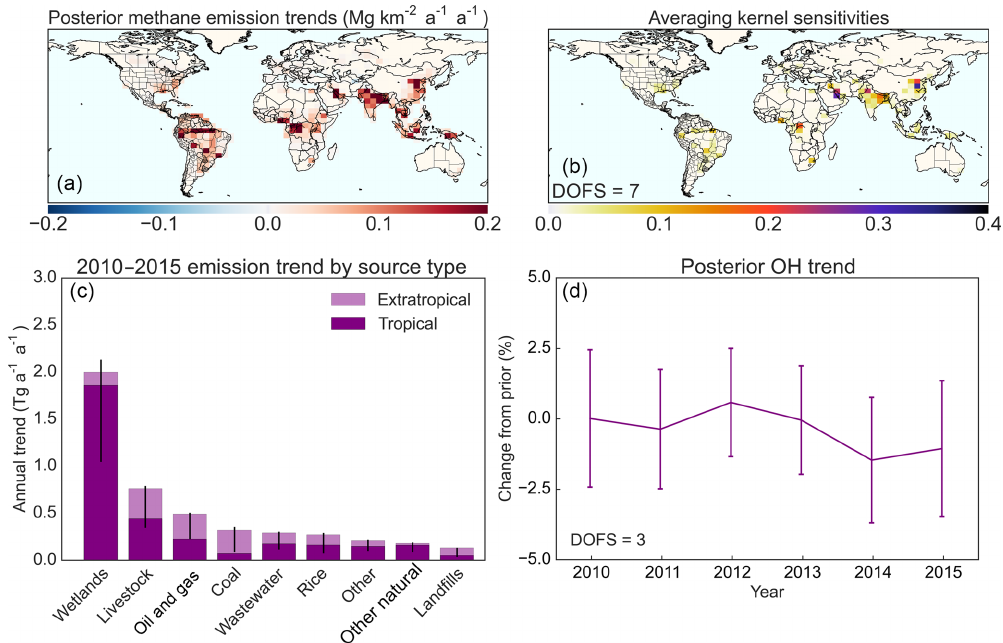
Figure 7. 2010–2015 methane emission trends and global tropospheric OH trends as optimized by the inversion of GOSAT data and corre- sponding averaging kernel sensitivities (diagonal terms of the average kernel matrix). The degrees of information for signal or DOFS (trace of the averaging kernel matrix) is shown inset. Panel (c) gives the global attribution of the emission trends to individual source types, with ranges from the inversion ensemble. Shaded sections of the bars indicate the contribution from the tropics (24 ◦ S–24 ◦ N). The vertical bars in the OH trend panel are the posterior error standard deviations from the base inversion. The 2010–2015 decreasing trend in OH concentrations is not statistically significant (95% confidence